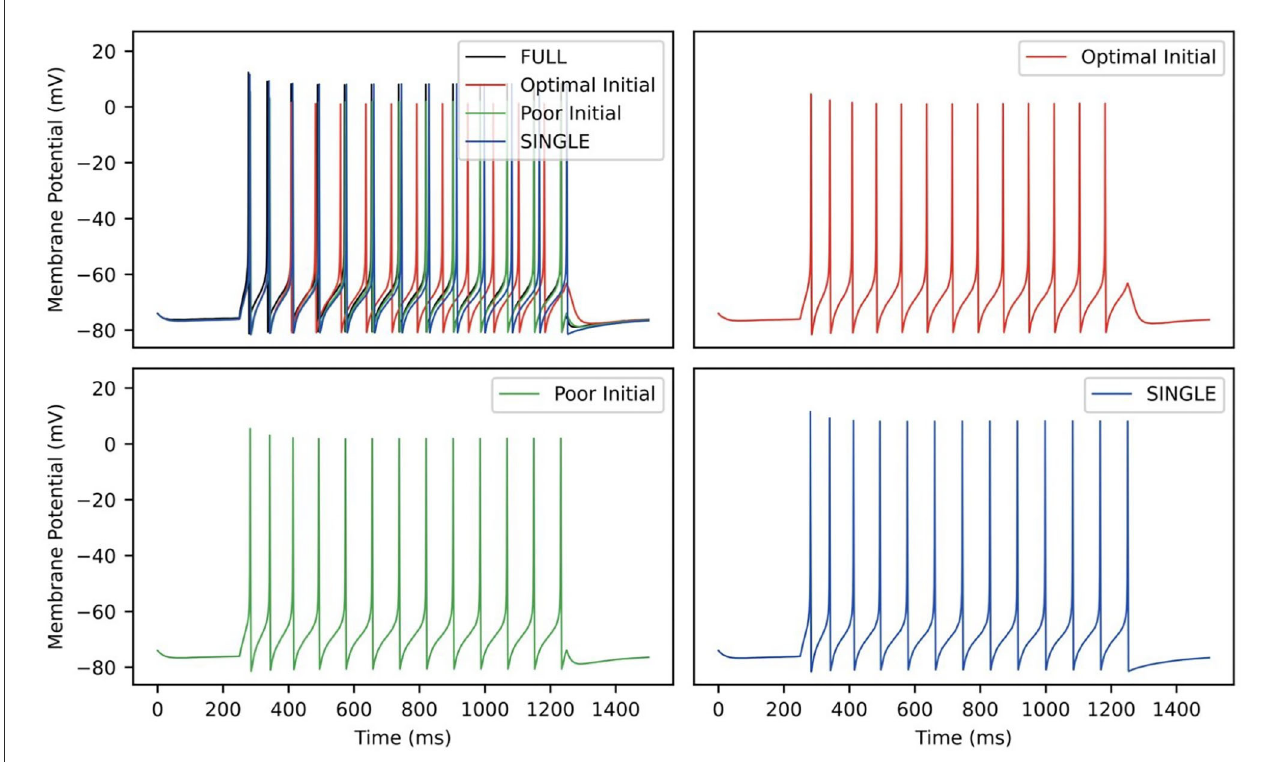
FIGURE11 RAUKF parameter comparison. Traces of FULL (black), SINGLE (blue) and RAUKF model poor and optimal estimates (green and red) to a step 60 pA step current for 1 s, similar to as shown in Figure 1. The traces of SINGLE and RAUKF are overlayed atop the FULL’s in the top left. The remaining corners are the traces of SINGLE and RAUKF separated for